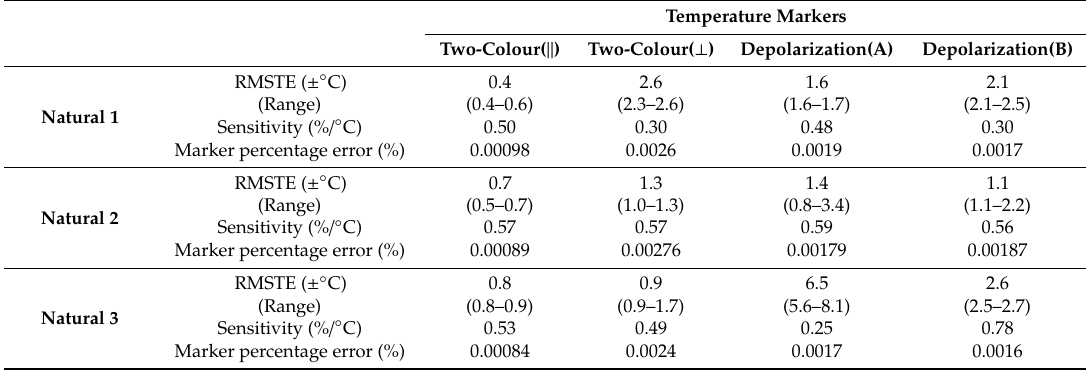
Table 3. RMSTEs, sensitivities, and the absolute percentage errors in each marker for natural water sample analysed by two-colour markers. Data in brackets is based on the analysis of 4 datasets; data without brackets is based on the “average markers” dataset. Refer to Section 2.1. for